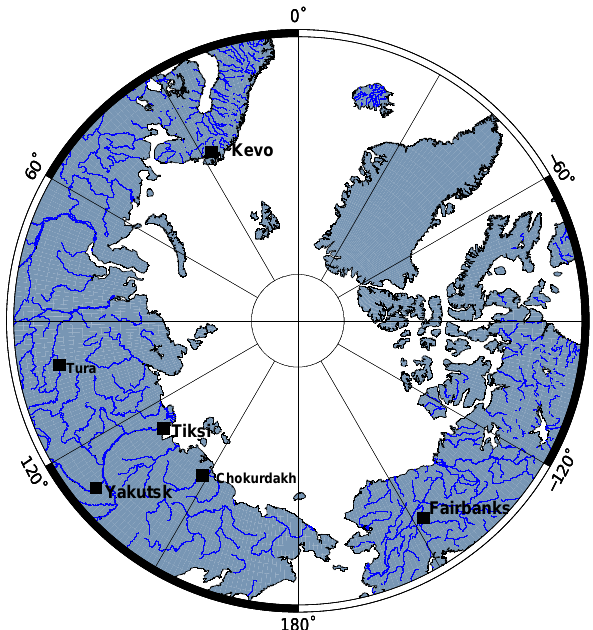
Figure 1. Location of the GTMIP observation sites (after Miyazaki et al.,